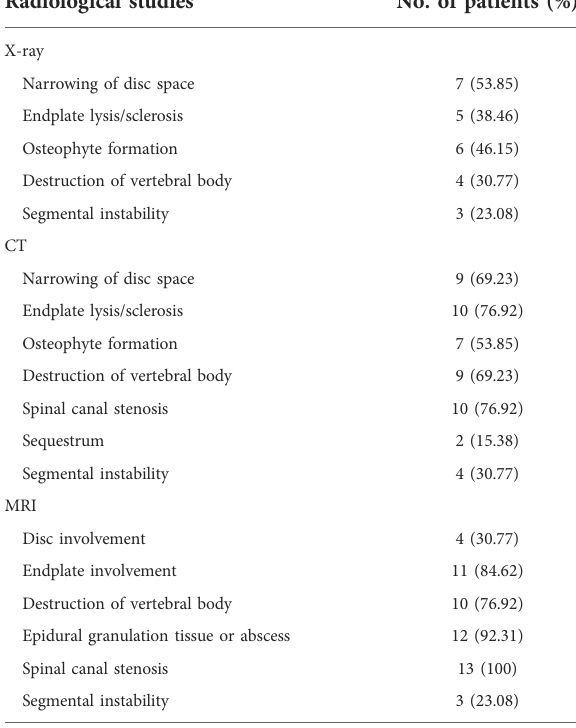
TABLE 2 Radiological data of all